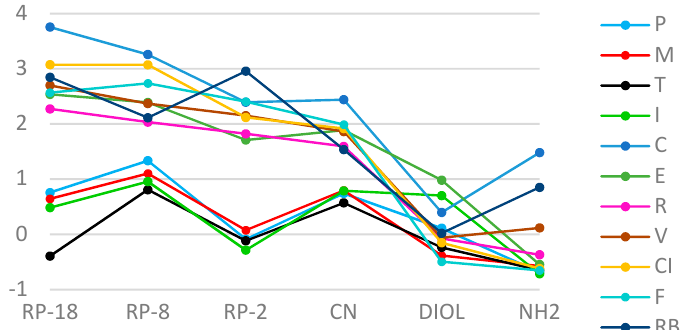
Figure 2. A plot of the relationship of R M0 values on the type of stationary phase for the tested substances in the acetone/water mobile phase.